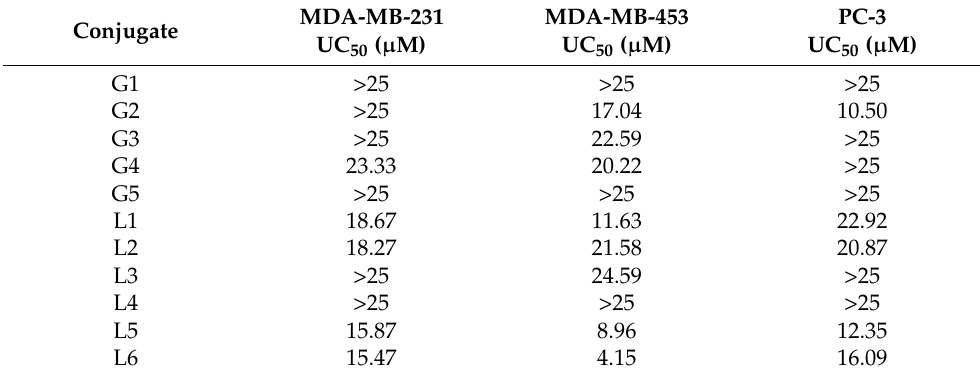
Table 3. UC 50 values related to the uptake of the conjugates in the indicated human cancer cell lines after 1.5 h incubation. Each value indicates the concentration ( µ M) that corresponds to the internalisation of 50% of the conjugate inside the living